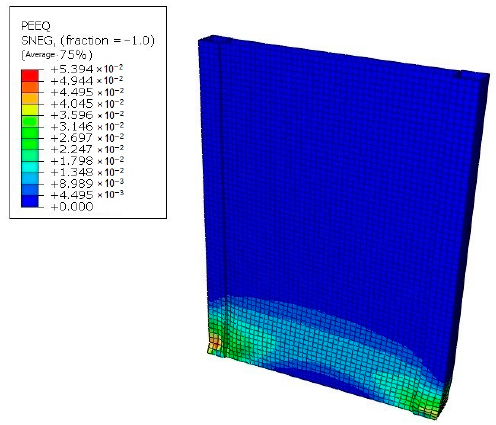
Figure 11. PEEQ of steel members for DSCW-1.